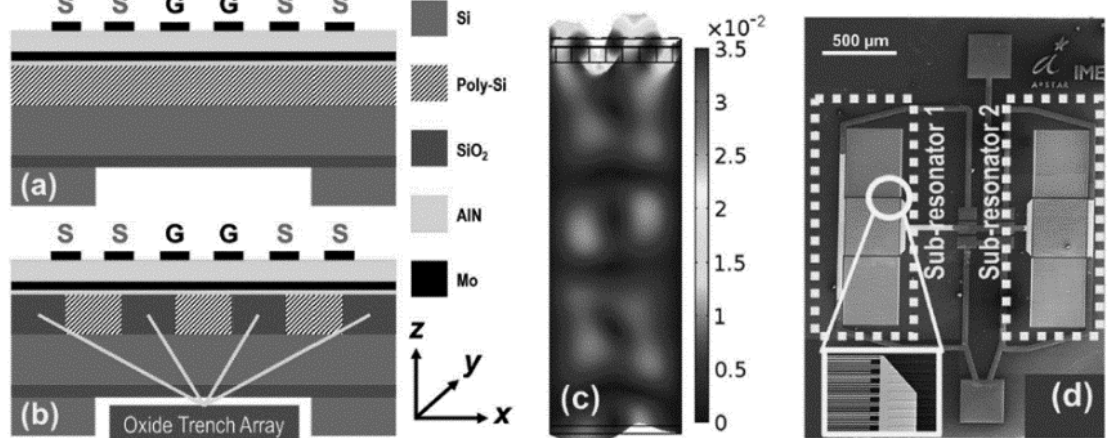
Figure 23. Dual-frequency resonating device ( a ) resonator without OTA; ( b ) resonator with OTA; ( c ) Displacement of the quasi-SAW mode shape of resonator; ( d ) SEM image of device. Reproduced with permission from [119]. Copyright © 2017, IEEE.